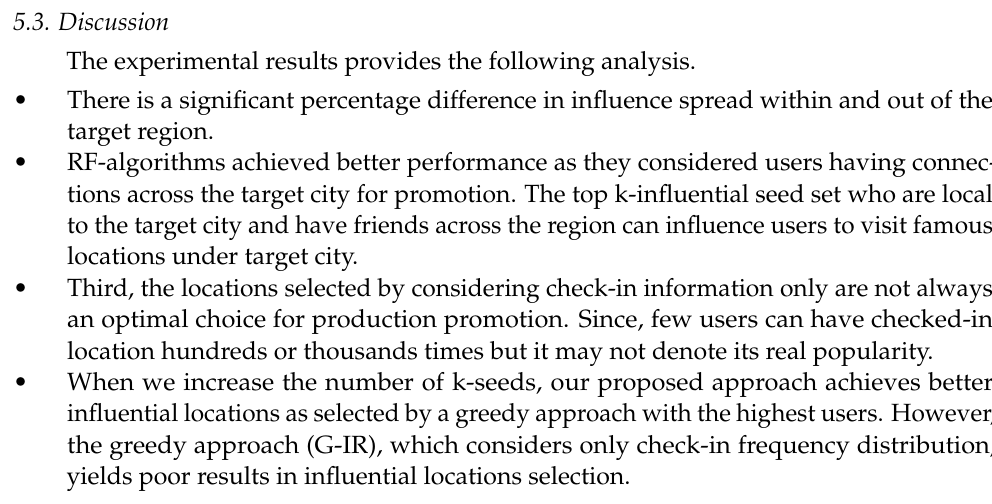
Figure 12. Top-10 influential locations in Log Angles using t-GIR algorithm considering